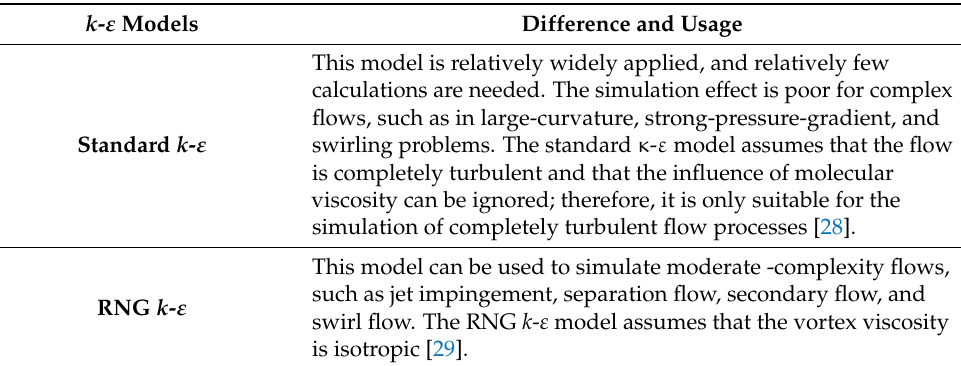
Table 2. Differences among and usage of different K-ε models.